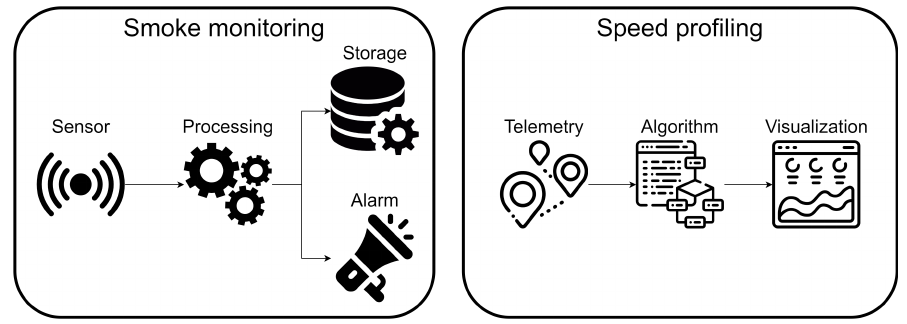
Figure 7. Railway applications.